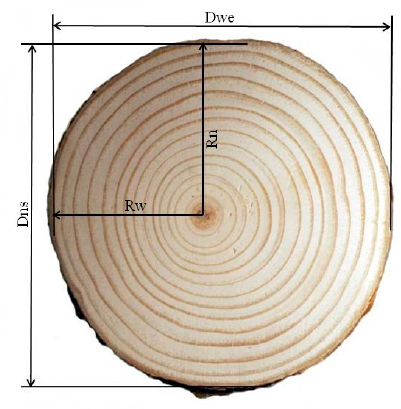
Figure 1. Measurement of the stem pith eccentricity.